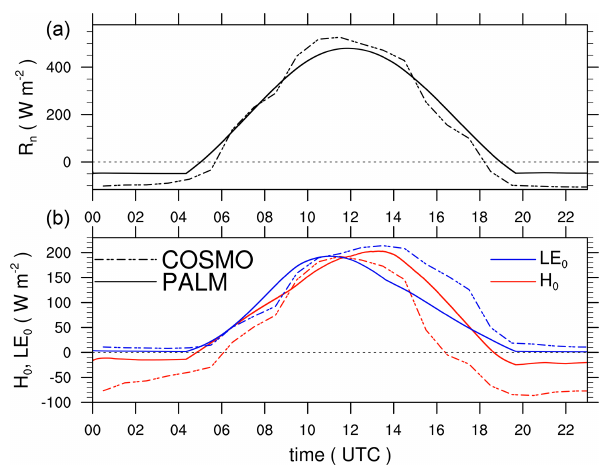
Figure 10. Time series of surface net radiation (a) and surface la- tent and sensible heat flux (b) from COSMO (dashed) and PALM (solid). Values are horizontally averaged over the corresponding do- main. The fine horizontal dashed line indicates zero surface net ra- diation and heat fluxes, respectively. Please note the different tem- poral resolution between PALM and COSMO, with COSMO values only defined